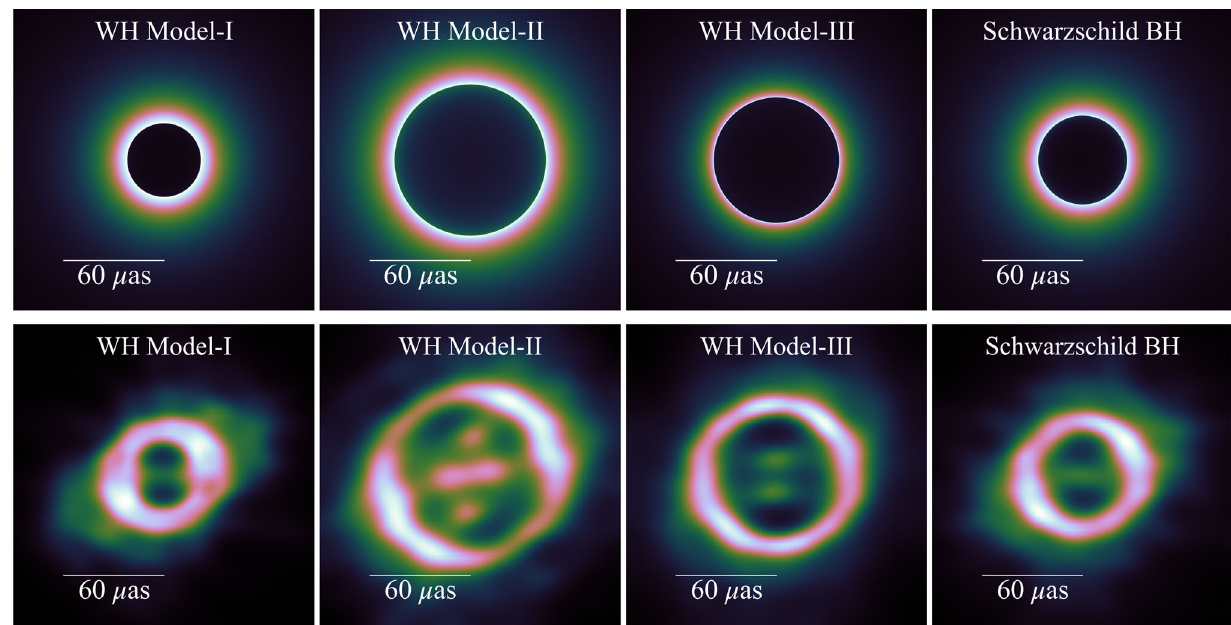
Fig. 7 Top row: Ray-traced images of shadows using the radially infalling gas model seen by a distant observer for three WH geometries andSchwarzschildBHrespectively.Bottomrow:Reconstructedimages